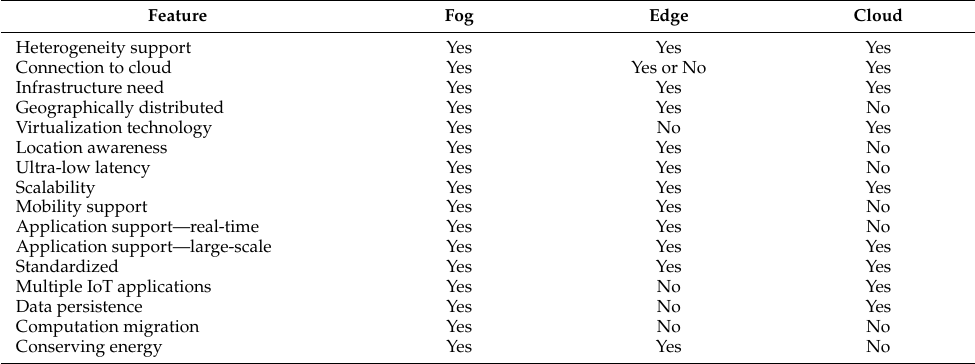
Table 4. Fog, edge, and cloud computing